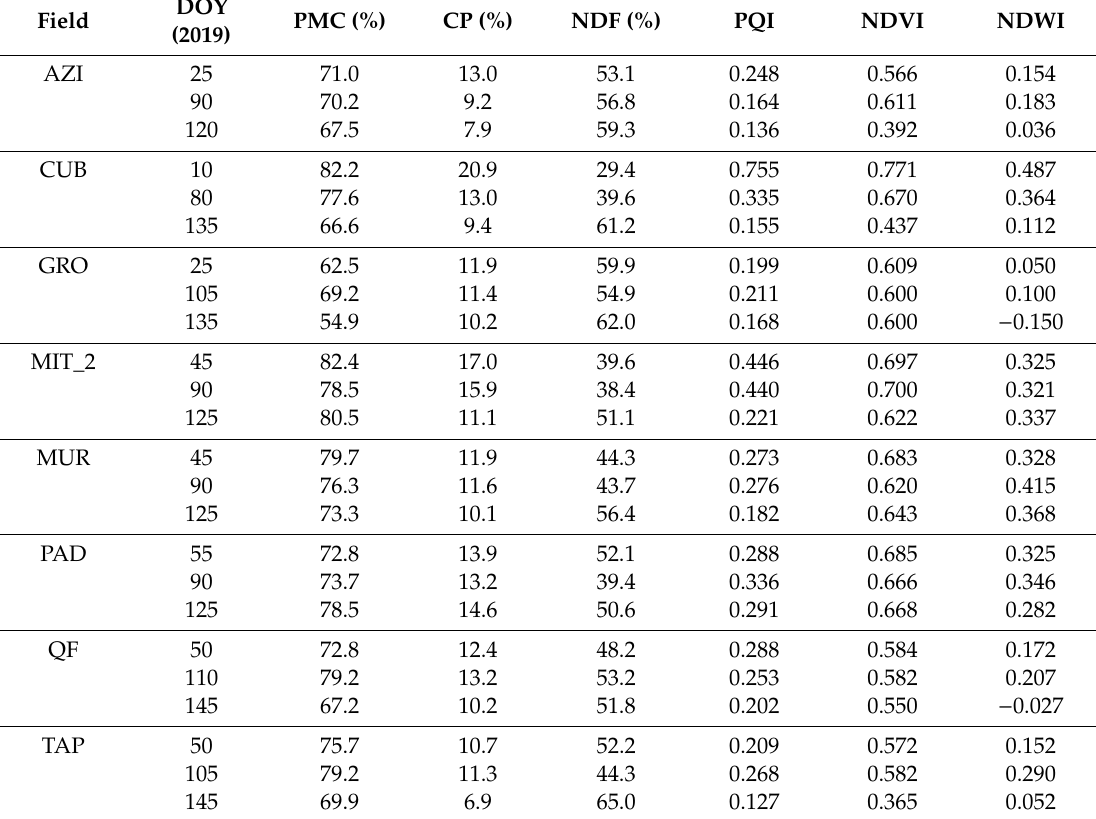
Table 4. Average PMC, CP, NDF, and PQI reference values and NDVI and NDWI values based on satellite